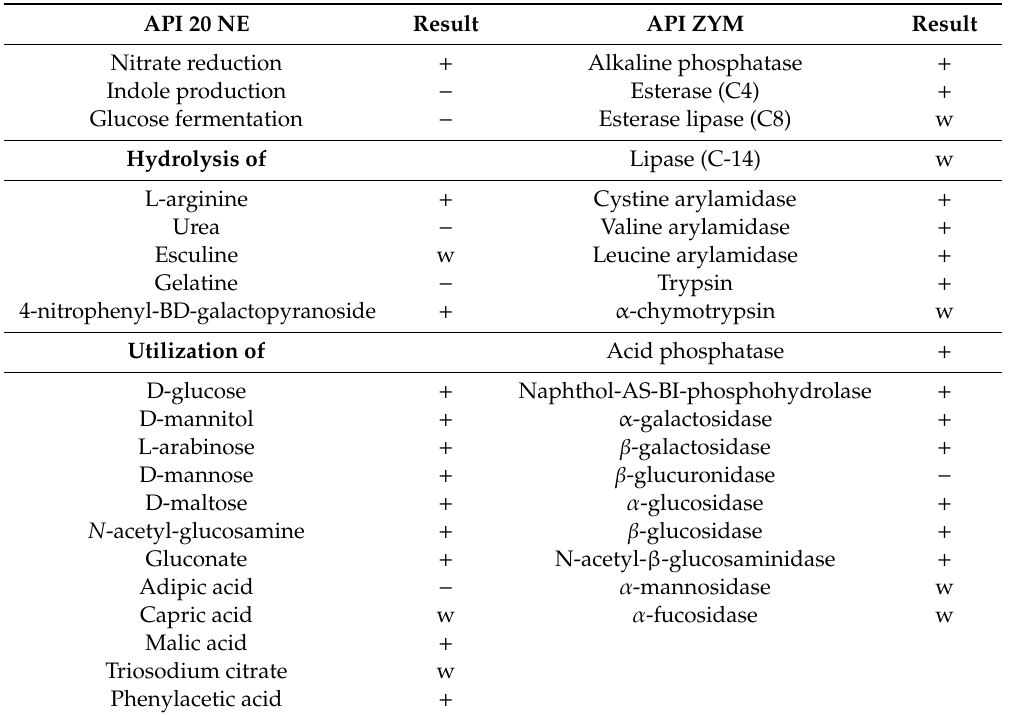
Figure 1. The neighbor-joining (NJ) tree on the basis of 16S rRNA gene sequences analysis demonstrating the phylogenetic relationships of isolated strain MAHUQ-39 with related type strains. Bootstrap values more than 70% are shown at branching points. The scale bar shows 0.05 substitutions per nucleotide position. Table 1. Biochemical characterization of Pseudoduganella eburnea MAHUQ-39.